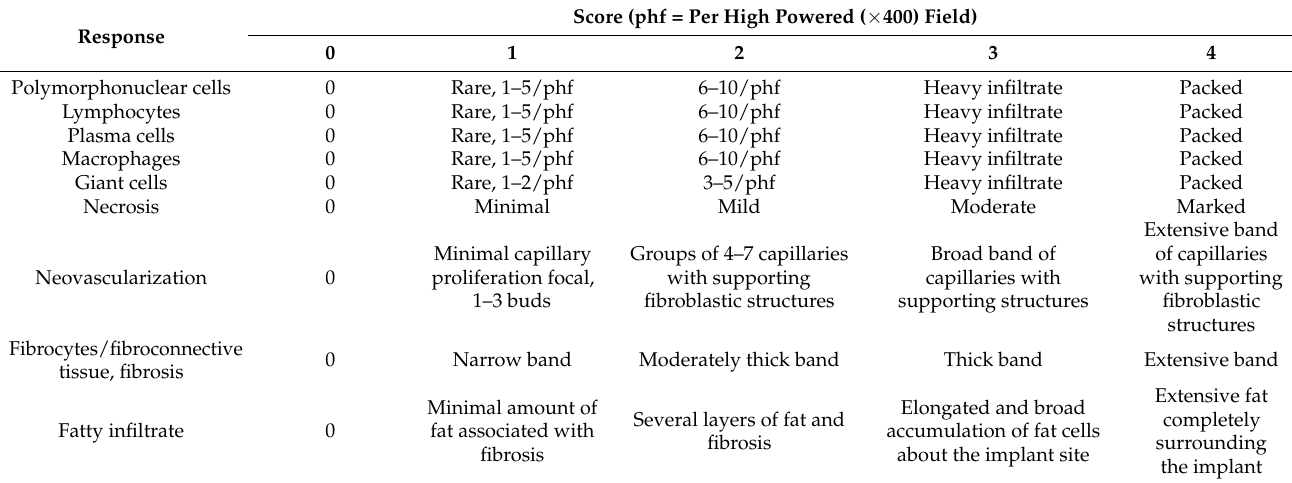
Table 2. Histologic Evaluation System for Irritancy/Reactivity—Cell